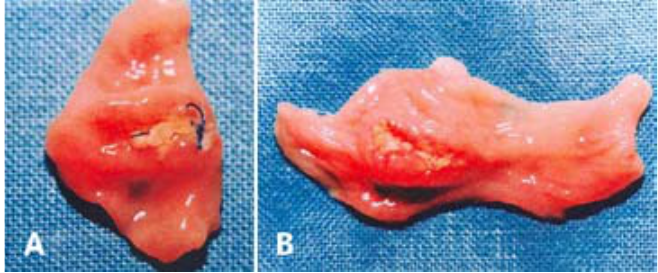
FIGURE 2 - Gross appearance of the 4 th postoperative day. A . Polypropylene. B . Poliglecaprone 25.